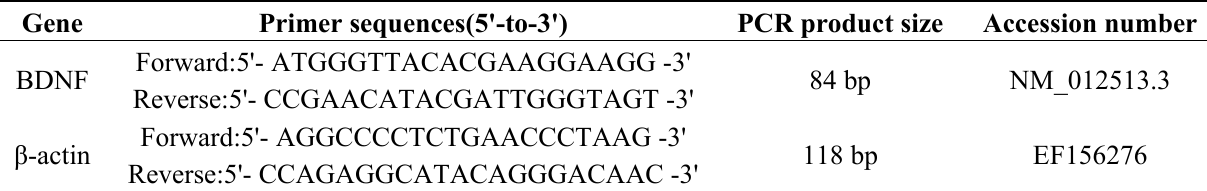
Table 2. Primer sequences used in real-time